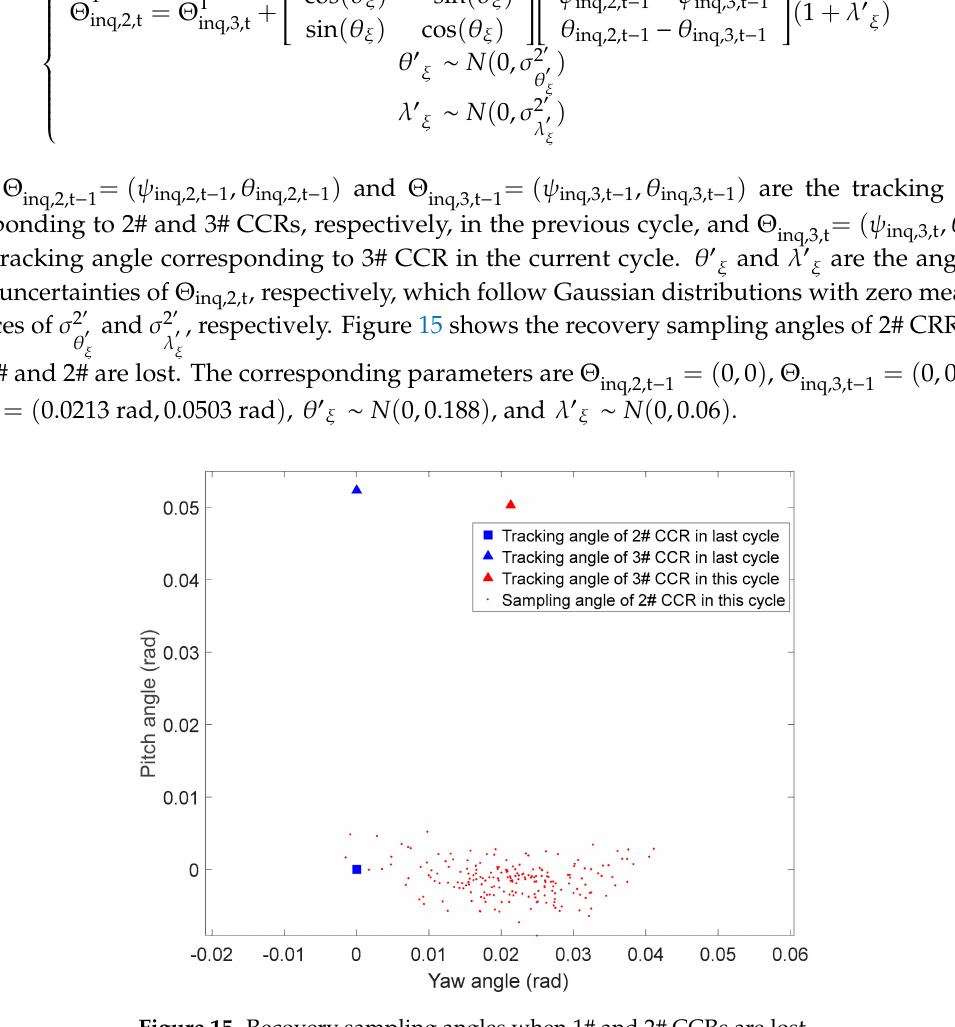
Figure 15. Recovery sampling angles when 1# and 2# CCRs are